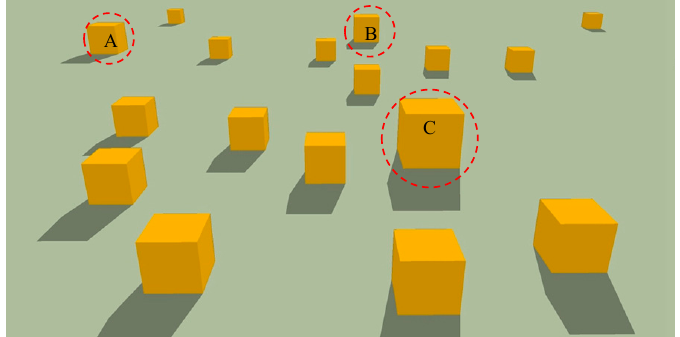
Figure 2. Stimulus used for G1-G6 in Exp. 1.3, intended to investigate size guidance. The participants were asked to find all the larger cubes ( A – C ); these labels were not shown to the participants). For Exp. 2’s stimuli, the distances were categorized as far, middle and near. The directions were labeled as either to the side or straight ahead, and the entire view was divided into 9 regions that were defined by these 6 different properties (Figure 3): side-far (A), side-middle (B), side-near (C), straight ahead-far (D), straight ahead-middle (E), and straight ahead-near (F). The regional contours were not shown to the subjects. Each region contained 3 objects, for 27 objects in total (Figure 4). One of the 3 objects was marked with its corresponding region code (A–F). The central object was marked